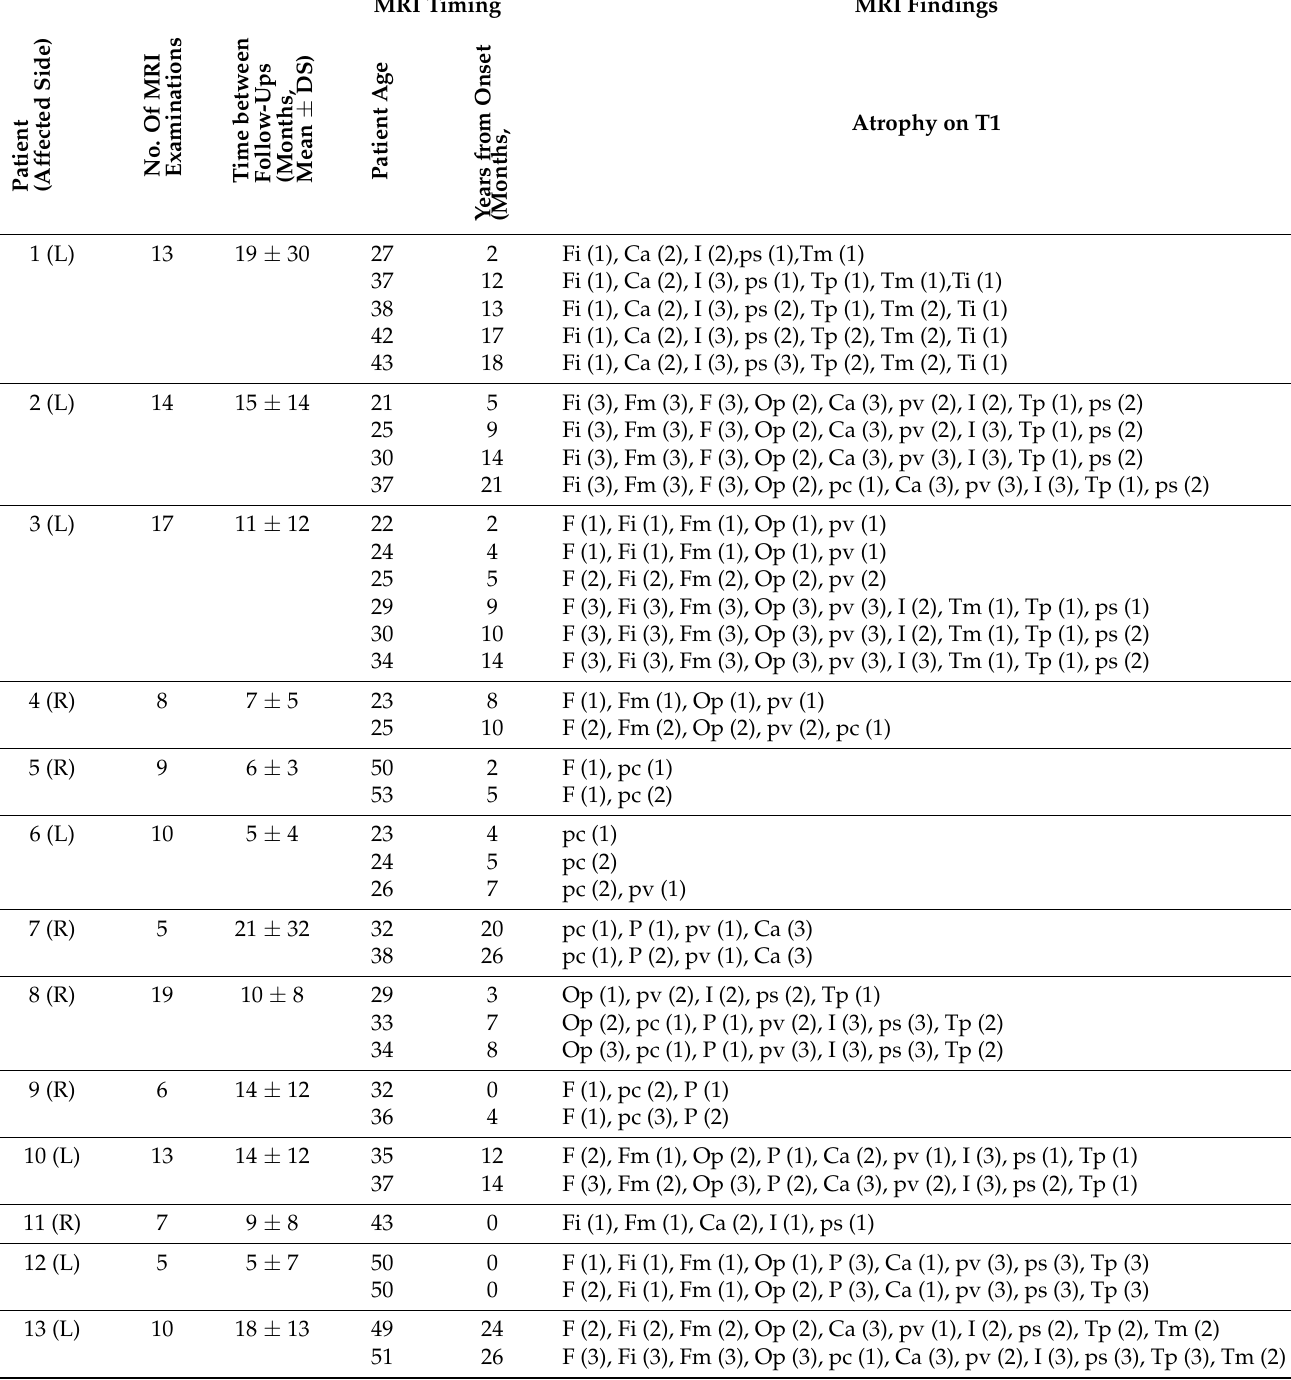
Table 2. Brain atrophy of 13 patients with Rasmussen encephalitis. Each row represents radiological findings when any change occurred (either in atrophy or in signal intensity); first and last MR exam details are always